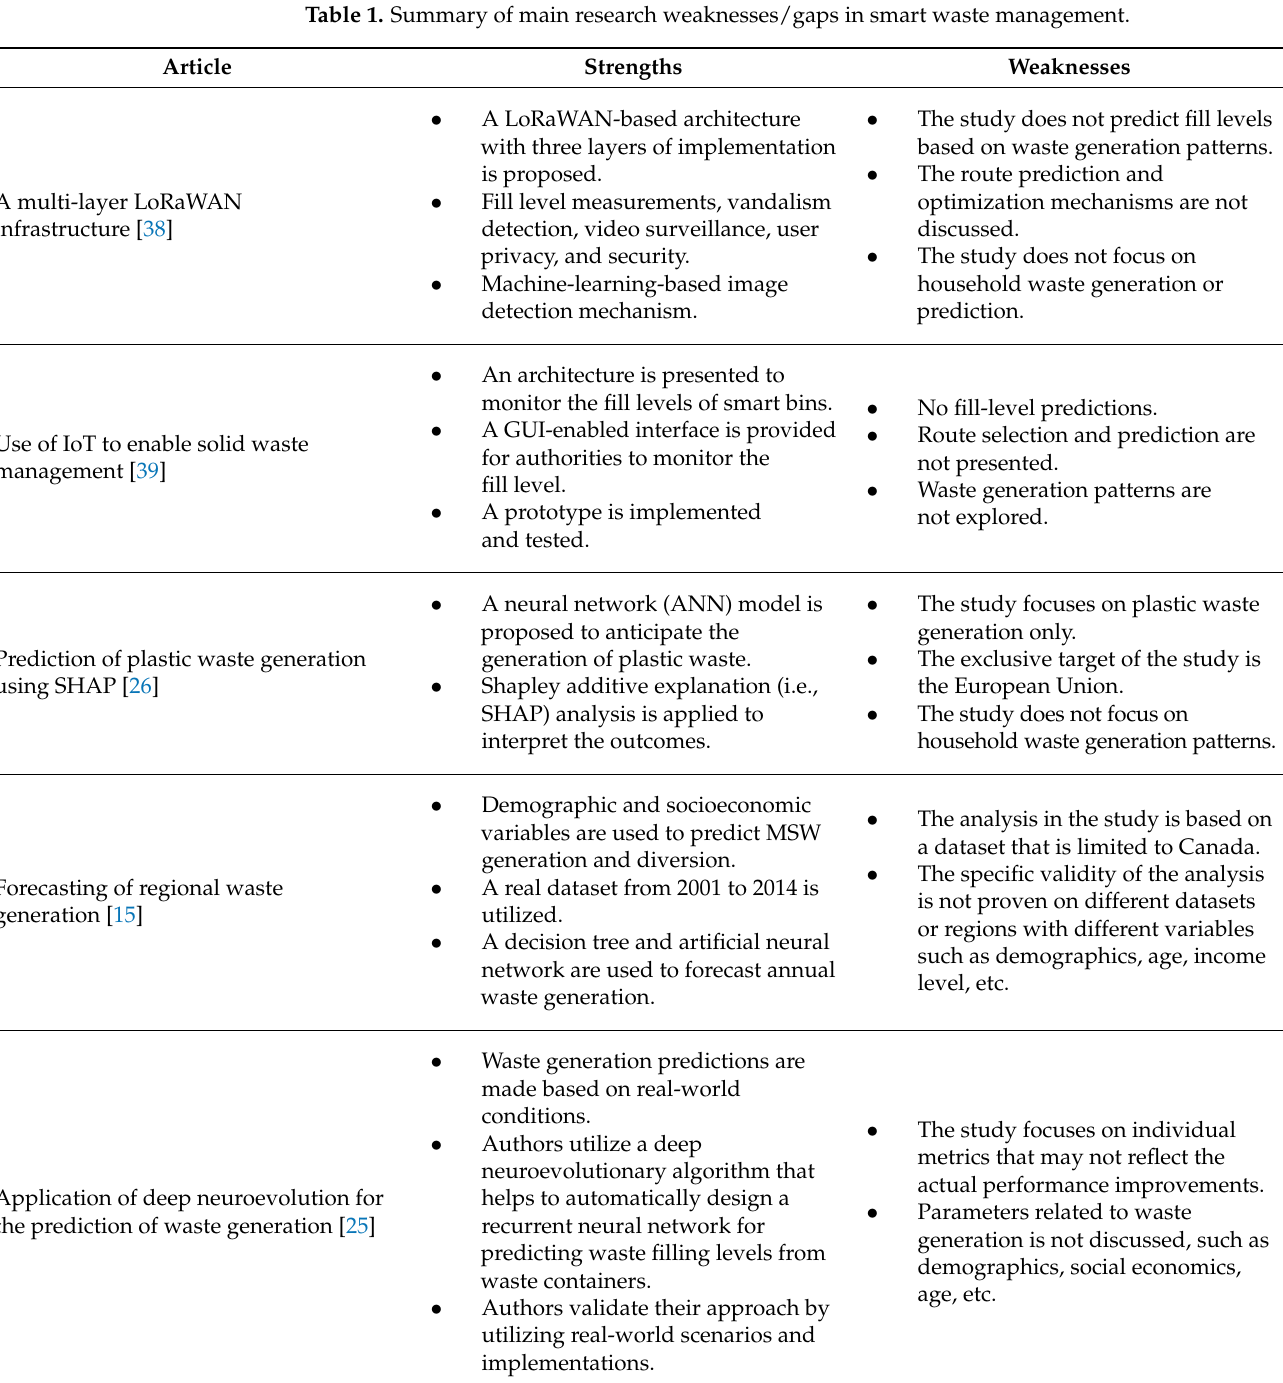
Table 1. Summary of main research weaknesses/gaps in smart waste